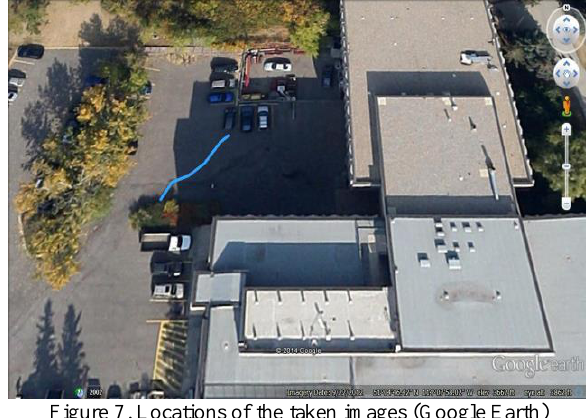
Figure 7. Locations of the taken images (Google Earth)